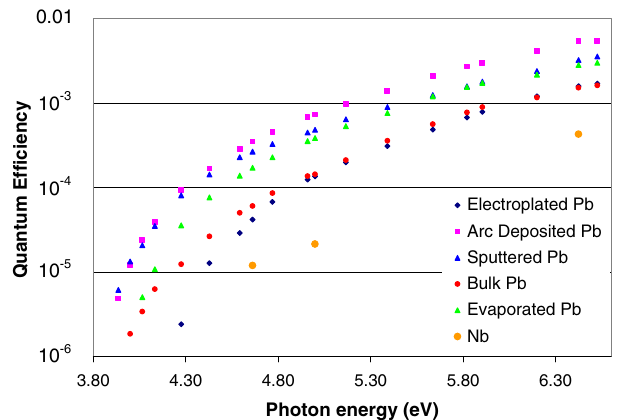
FIG. 11. (Color) (cid:2) QE (cid:3) 1 = 2 vs photon energy for sputtered lead.